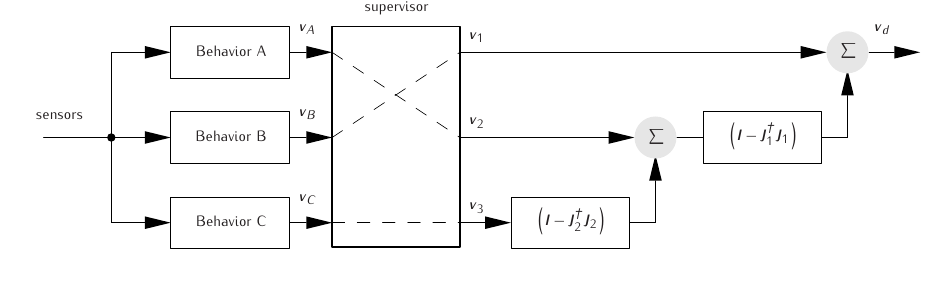
Figure 2. Sketch of the Null-Space-based Behavioral control in a 3-behavior example given by equation 9.